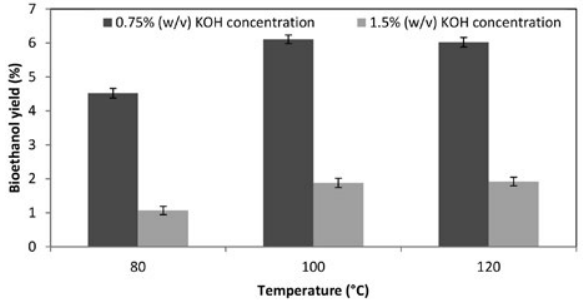
Fig 5. Effect of different alkaline pre-treatment temperatures on bioethanol yield